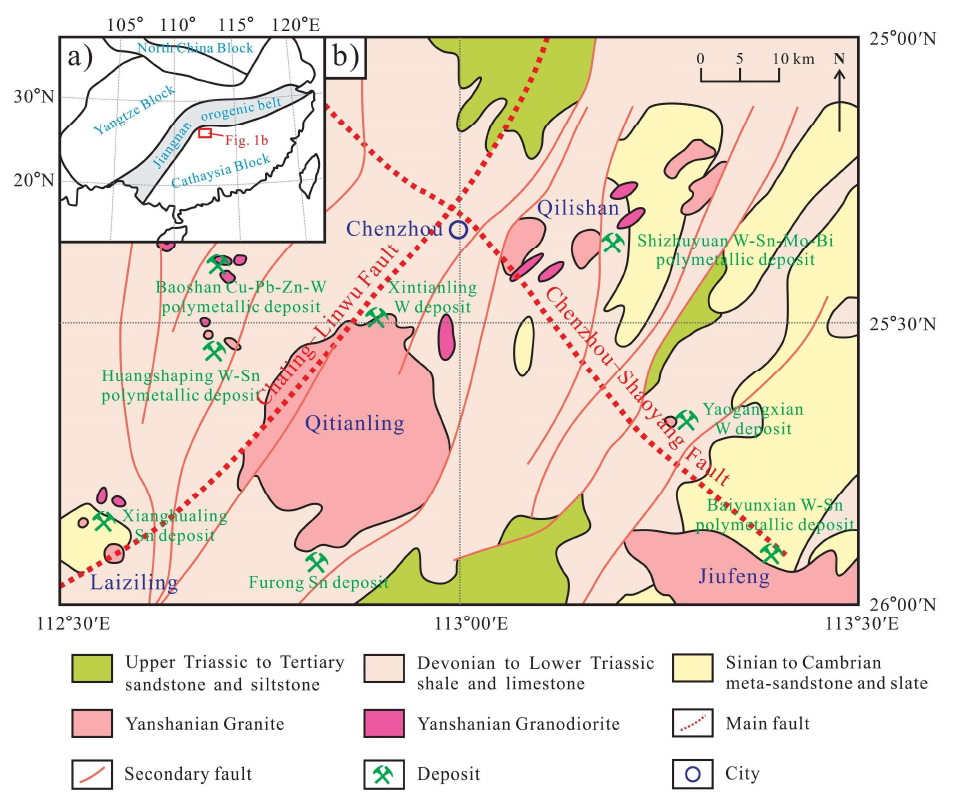
Figure 1. ( a ) Simplified map of plate tectonic pattern in South China [31]; ( b ) simplified geological map of the South Hunan [31].